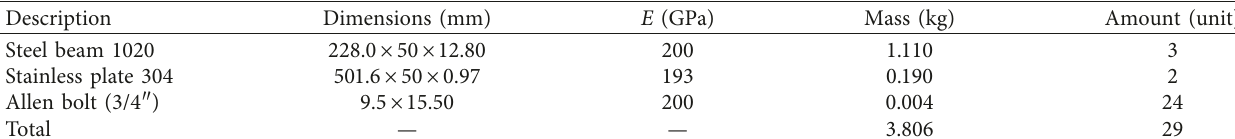
Table 1: Description of the components used in the structural construction.